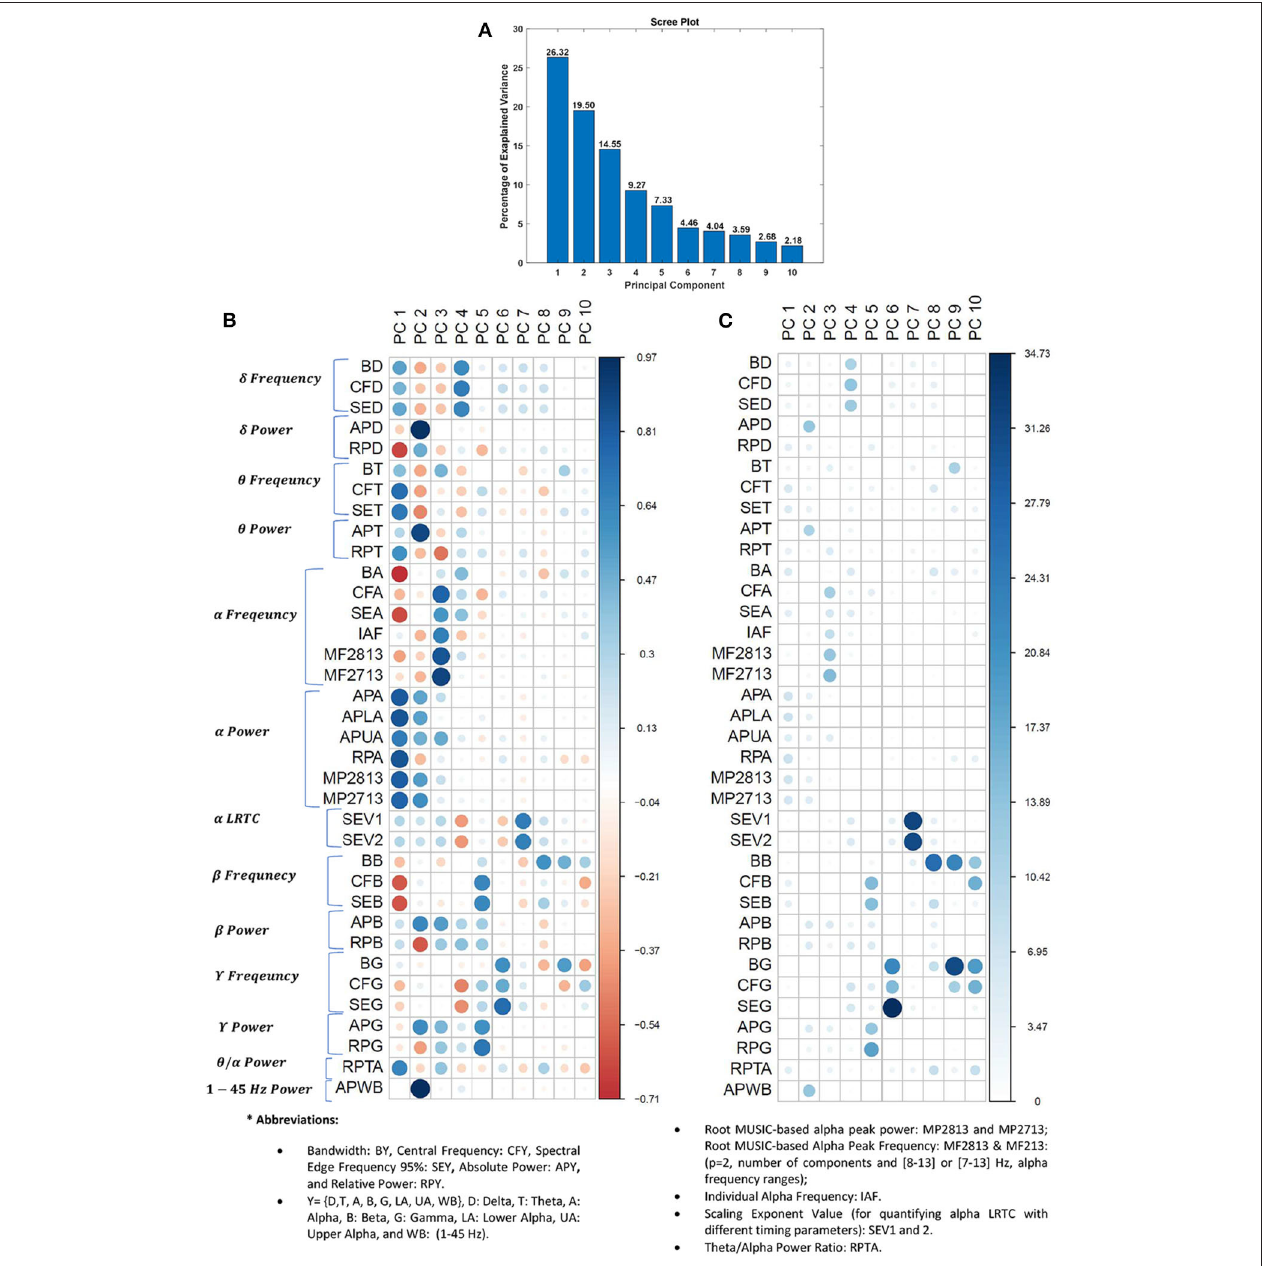
FIGURE 3 | PCA on EEG features. (A) Scree plot displays the percentage of explained variance in a downward curve, ordering the eigenvalues from largest to smallest. (B) The coordinates of EEG features in PC domain in the rows. The positive and negative correlation values between features and PCs are visualized by cool and warm colors, respectively. (C) The contribution of EEG feature to the PCs in percentage, i.e., the squared coordinates were normalized to total sum of squared coordinates on the PCs. The larger and darker circles indicate the EEG features contributes more to the given component. The difference between (B,C) is that the (B) shows the correlation between features and PCs, while (C) shows the representation quality of features on the PCs (i.e., normalized squared correlation values in percentage).